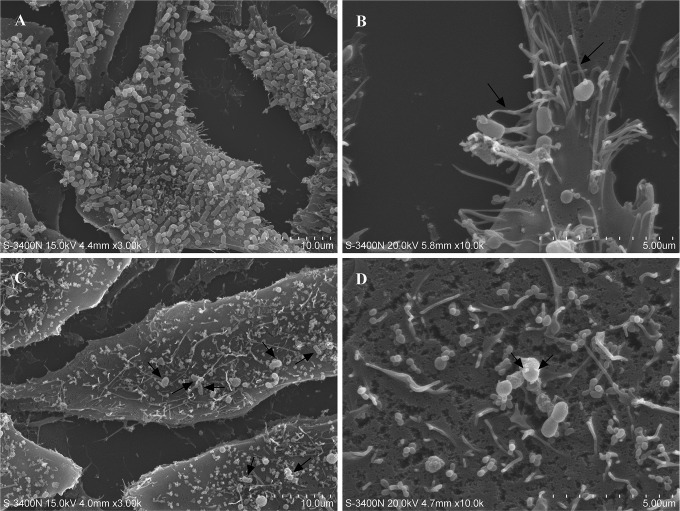
SEM image showing Escherichia coli O157:H7 adhering to HeLa cells. (A and B) HeLa cells adhered by the exponential-phase cells. (C and D) HeLa cells adhered by the VBNC cells. Left images, magnification of ×3,000; right images, magnification of ×10,000.